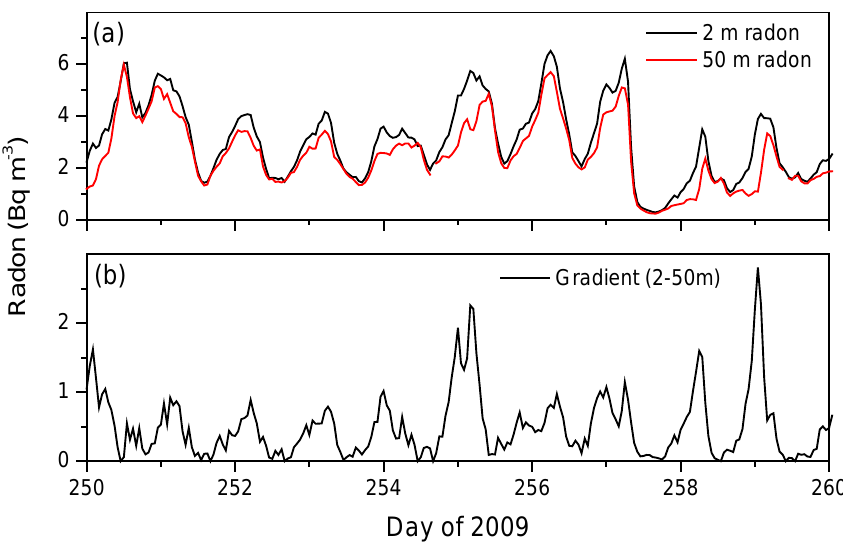
Figure 2. (a) 2 and 50ma.g.l. hourly radon concentrations at Lucas Heights, 30km southwest of Sydney, in September 2009, and (b) the corresponding hourly radon gradient.